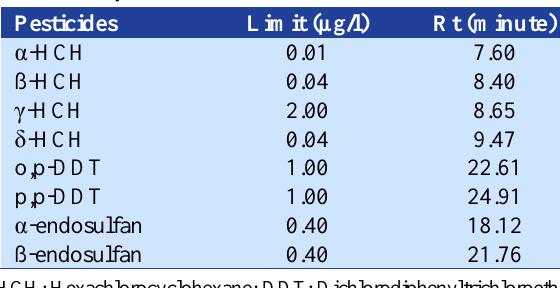
Table 1. Pesticide residue limits (Bureau of Indian